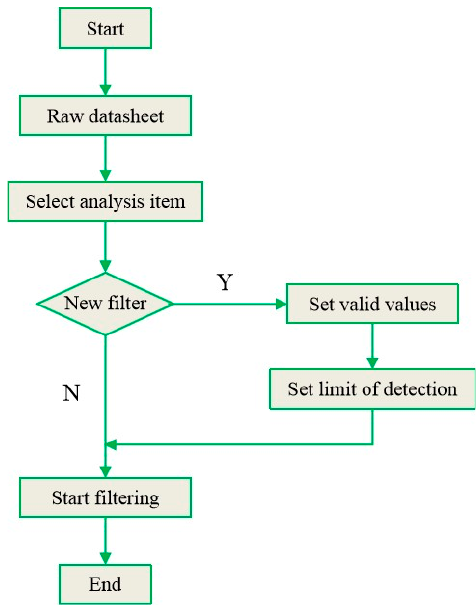
Figure 3. Data filtering workflow.